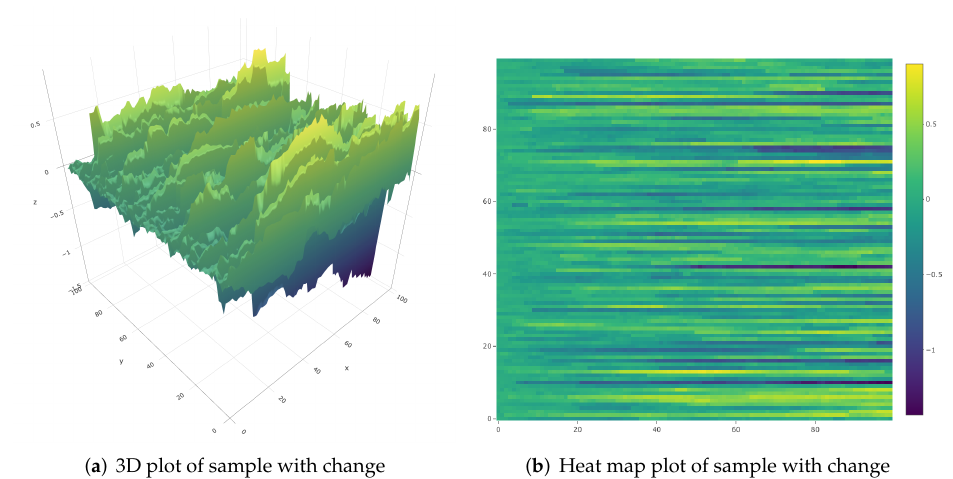
Figure 9. Sample with introduced drift of magnitude a = 0.004 after the change-point.